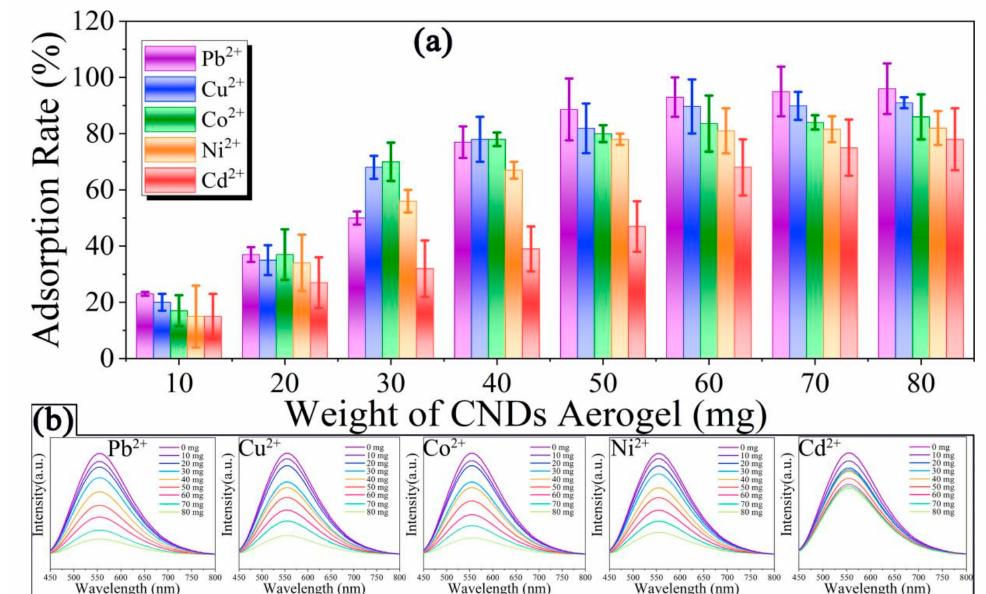
Figure 4. ( a ) The adsorption rate of CNDs aerogel for Pb 2+ , Cu 2+ , Co 2+ , Ni 2+ , Cd 2+ with the addition of CNDs aerogel. ( b ) The change of fluorescence intensity of CNDs aerogel with the content of Pb 2+ , Cu 2+ , Co 2+ , Ni 2+ , Cd 2+